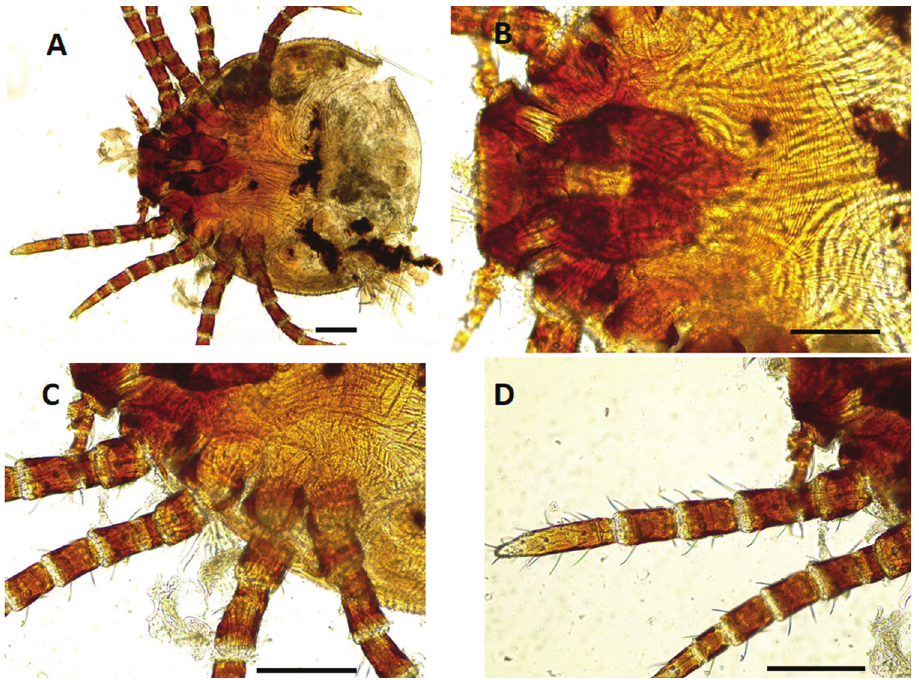
Figure 5. A specimen of Spelaeorhynchus praecursor , 40× magnification B detail of gnatossome, 100× C detail of legs, 100× D detail of leg and setae, 100×. Leica DM500 optical microscope. Scale bars: 0.5 mm ( A–D